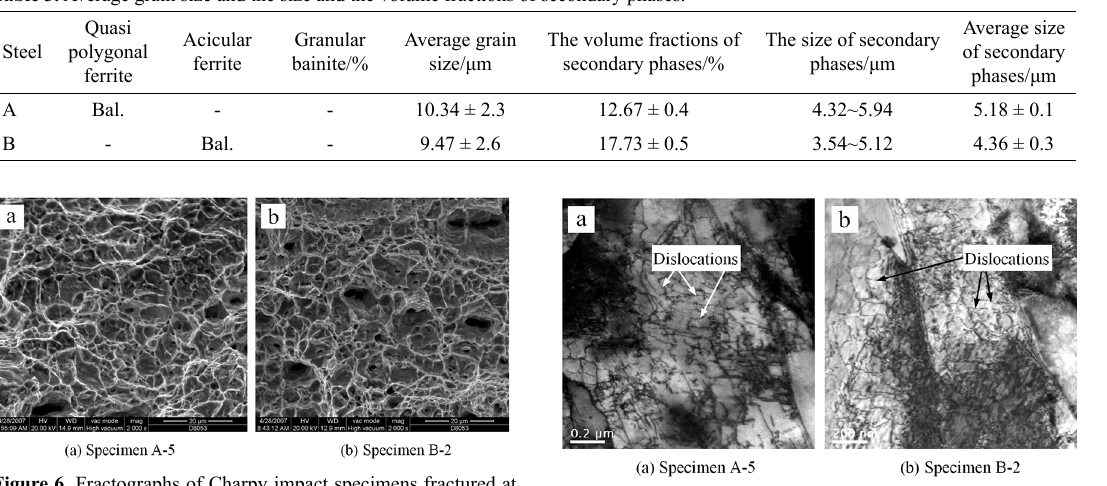
Figure 9. TEM micrographs of dislocations in ferrite observed in specimens.